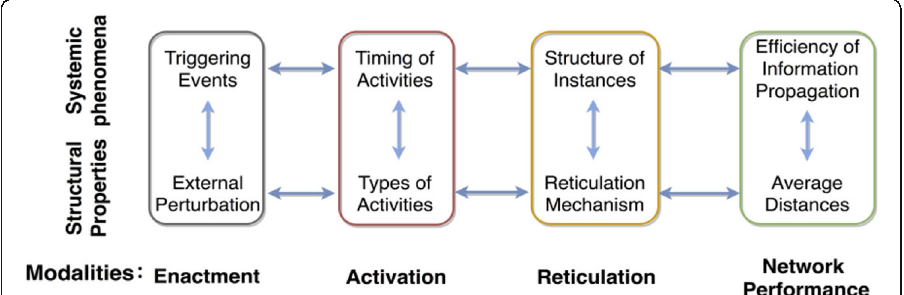
Fig. 1 Online network reticulation framework for characterizing dynamics of online social networks. This framework is composed of four modalities: enactment, activation, reticulation, and network performance, which can capture the dynamic behavior of users on social